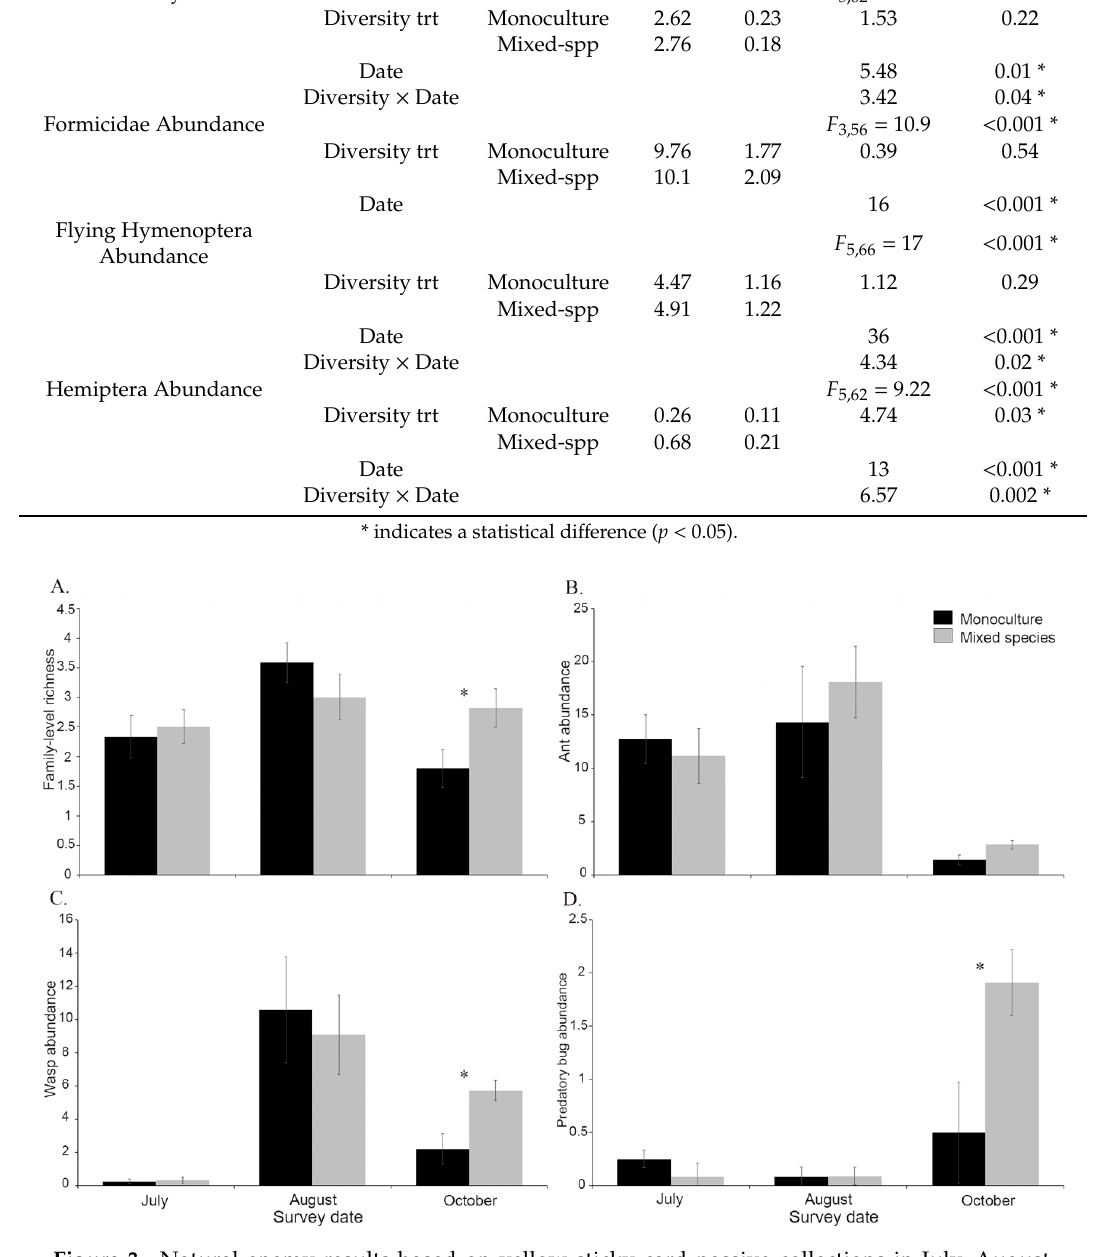
Table 2. Results comparing average natural enemy richness, Formicidae abundance, flying Hymenoptera abundance, and predatory Hemiptera abundance between monoculture and mixed-species diversity treatment plots across three survey dates in 2019.